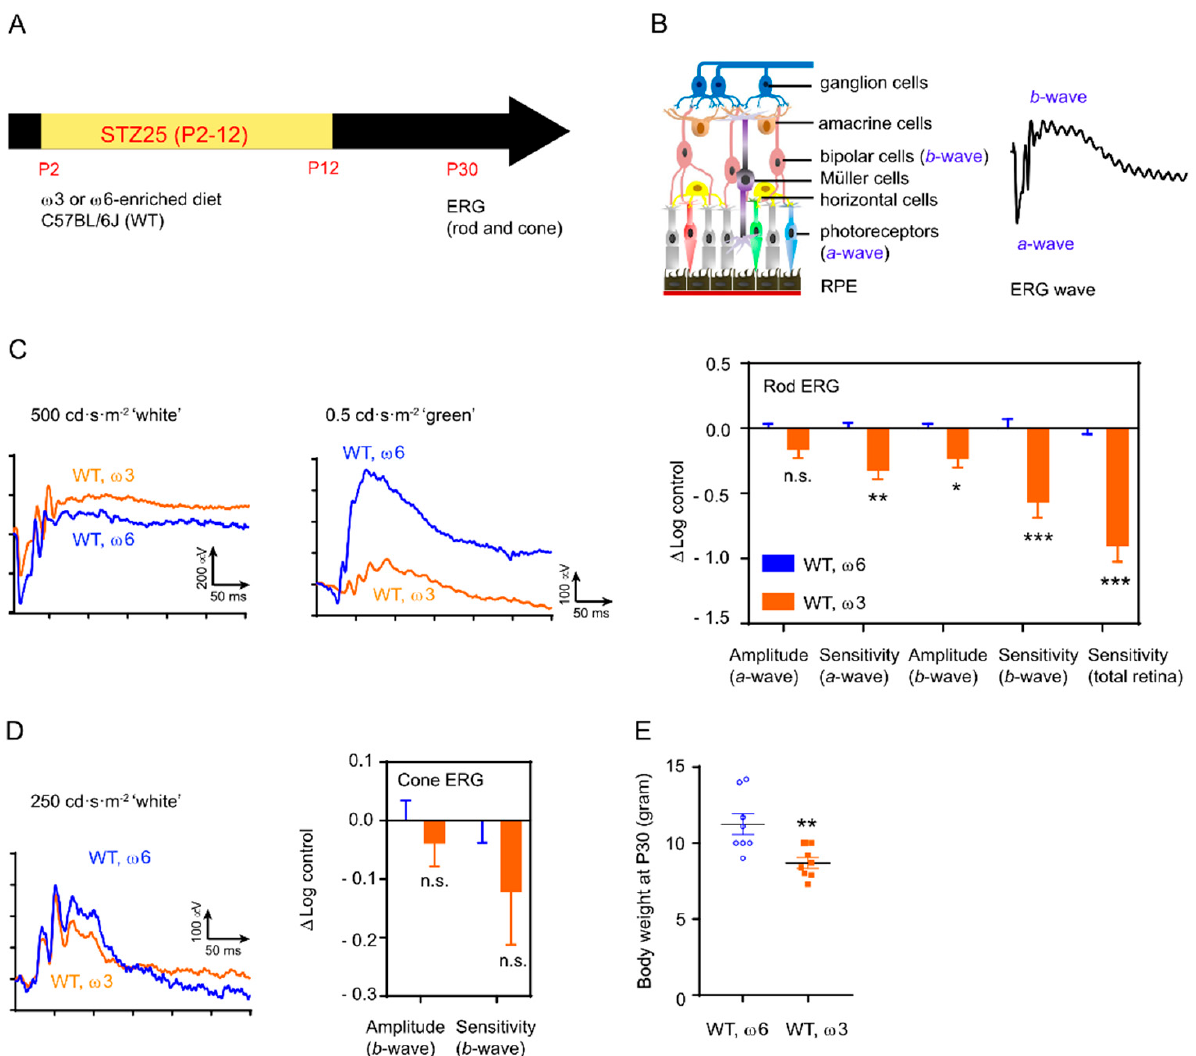
Figure 7. Shortage of dietary ω -6 LCPUFA delayed retinal functional development in Phase I ROP at P30. All ERG data are presented as the log change from control ( ∆ Log control) and normalized to that from ω -6-diet-fed group. Data are presented as mean ± SEM. ( A ) Schematics of hyperglycemic induction in C57BL/6J mice. An amount of 25 mg/kg STZ was i.p. injected daily from P2 to P12. The mice were fed on ω -3 or ω -6 LCPUFA-enriched diet from P1 until P30. ( B ) Schematics of ERG wave and corresponding retinal neurons: a-wave (photoreceptors), b-wave (bipolar cells). ( C ) ω -3 versus ω -6 LCPUFA diet decreased rod pathway responses in Phase I ROP mice. Representative rod ERG plots with ‘white’ (for maximal a-wave) and ‘green’ (for maximal b-wave) light stimulation are shown. n = 13–14 eyes. Multiple t -test. * p < 0.05, ** p < 0.01, *** p < 0.001, n.s., no significance. ( D ) No significant changes in cone ERG amplitude and sensitivity of bipolar cells in ω -3 versus ω -6 LCPUFA fed mice. Representative cone ERG plots are shown. n = 13–14 eyes. Multiple t -test. n.s.,